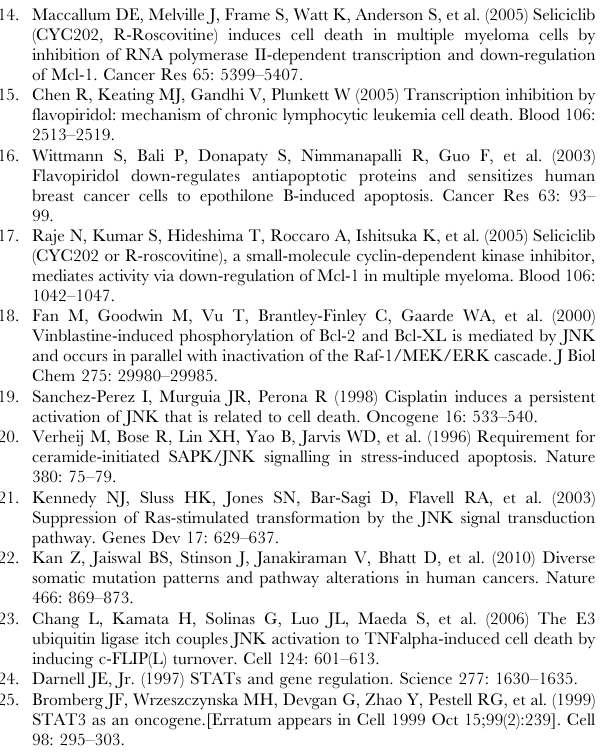
A498 cells. The mRNA levels were normalized with that of GAPDH. (TIF) Figure S3 Cell viability of A498, A498 STAT3-CA and A498 STAT3-DN cells after treatment with 1 m M NSC- 743380 for 12 h. Cells treated with DMSO were used as controls and set as 1. Cell viability was assayed 12 h after treatment by the SRB method. Each data point represents the mean 6 SD of three independent experiments. (TIF) Text S1 Method for synthesis, purity determination and structure identification of NSC-743380. (DOCX) Text S2 Quantitative PCR for mRNA